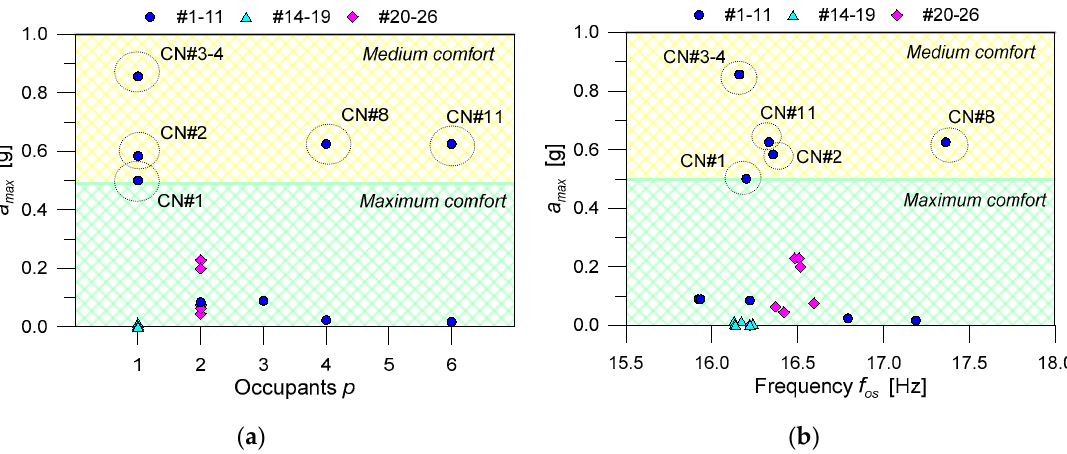
Figure 12. Vibration serviceability assessment of the examined system, based on the SÉTRA guideline document. Experimental acceleration peaks (average values, vertical direction), as a function of ( a ) number of occupants and ( b ) frequency.